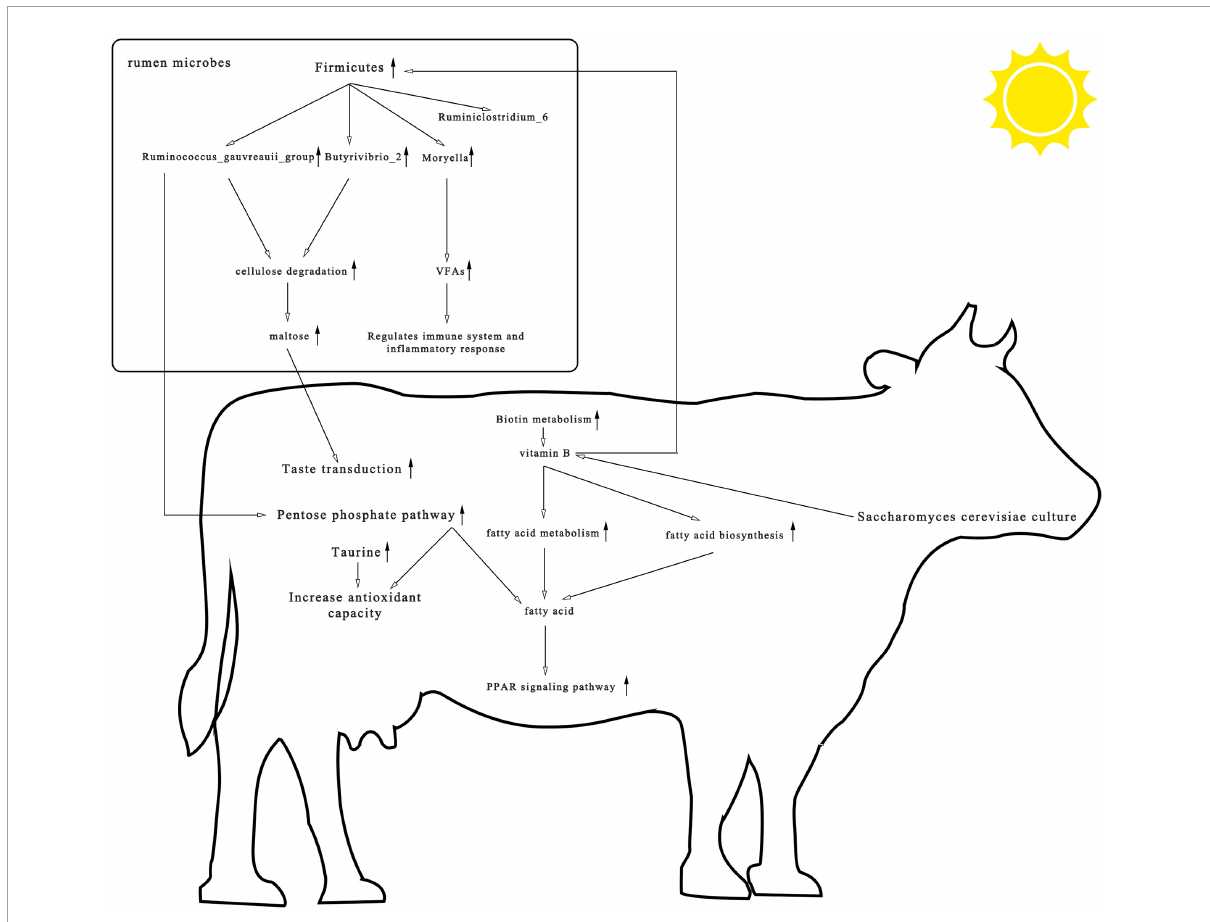
FIGURE8 Consolidation of rumen microbial composition, pathways, and differential metabolite results found among heat-stressed cows fed with Saccharomyces cerevisiae cultures. The upward arrow represents the increase in rumen microbial composition, pathways, and differential metabolite after the addition of S. cerevisiae